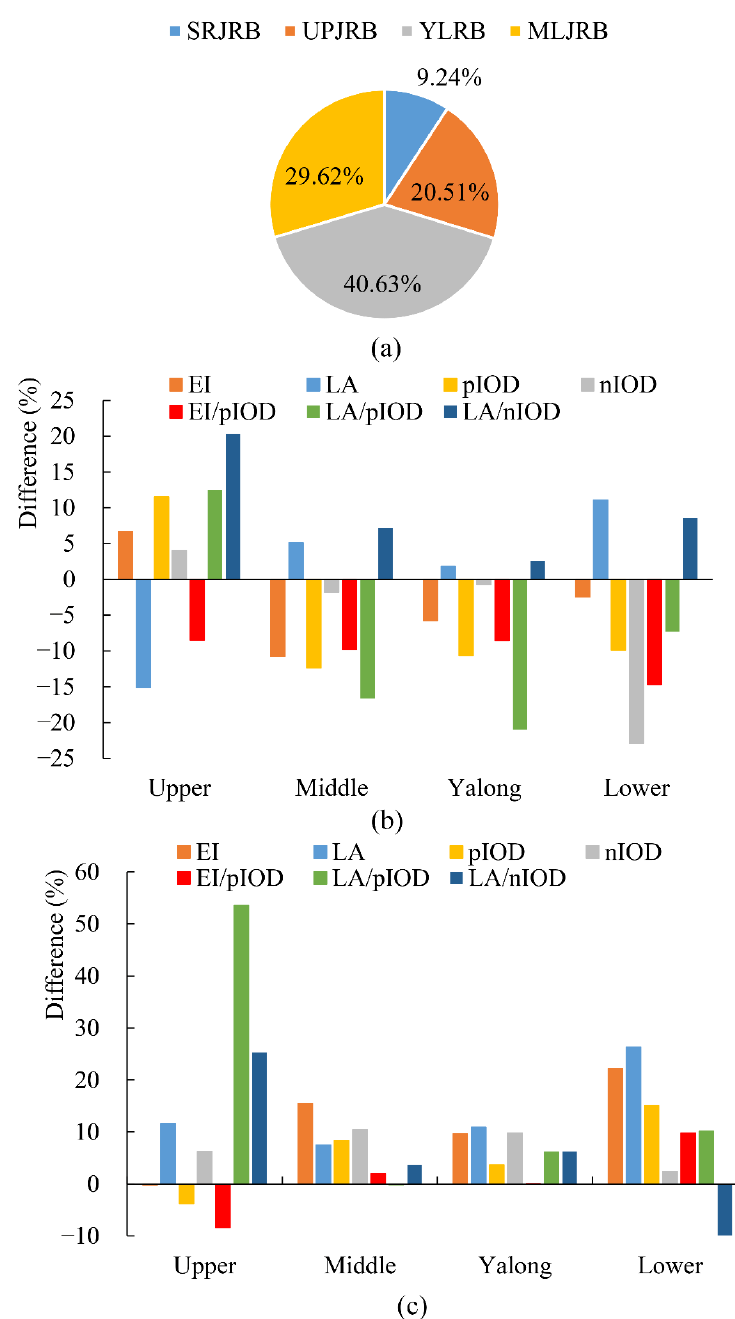
Figure 7. ( a ) Streamflow proportions of the four sub-basins in the Jinsha River Basin. Annual streamflow in different sub-basins relative to those corresponding to neutral years in, ( b ) developing years, and ( c ) decaying years.